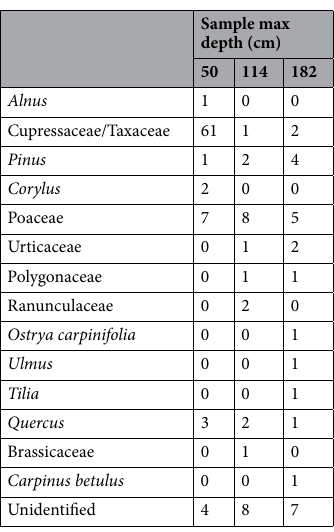
Figure 3. Pollen grains retrieved from the ice core and analysed by light microscopy. Pollen grains of Alnus ( a ), Ambrosia ( b ), Artemisia ( c ) and Pinus ( d ).